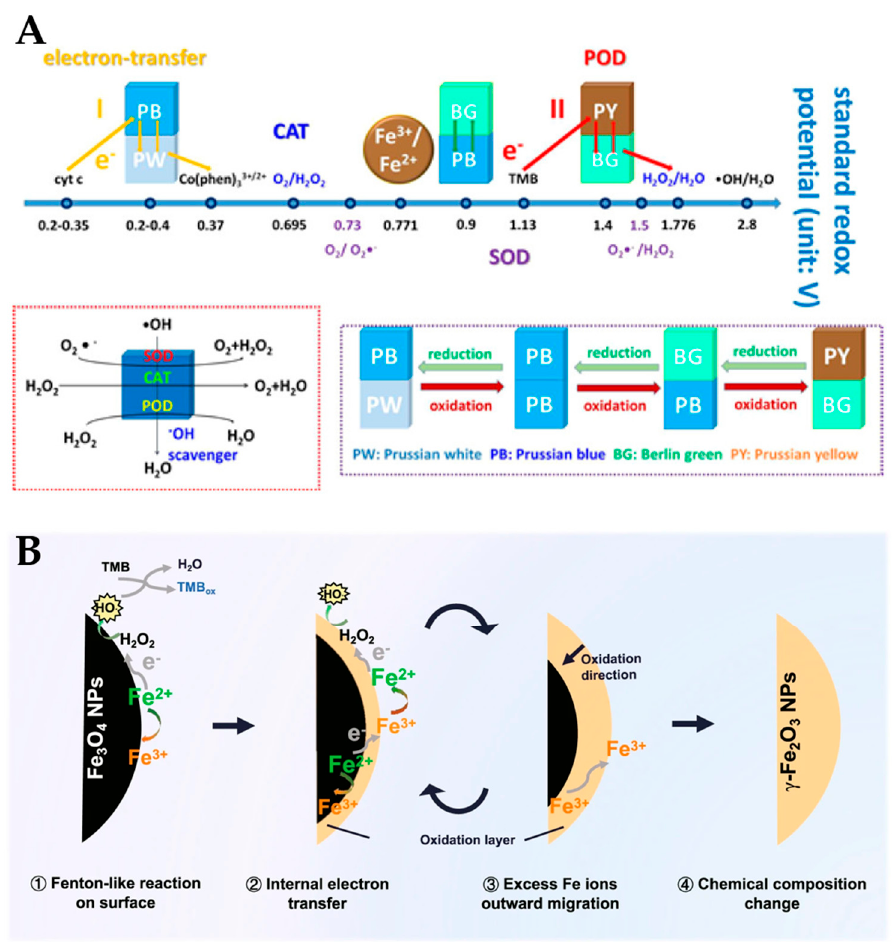
Figure 2. ( A ) The mechanism of the multienzyme − like property of PB NPs, based on standard redox potentials [19]; ( B ) the mechanism of the POD-like property of Fe 3 O 4 NPs [20]. Copyright: American Chemical Society and Nature Publishing Group.